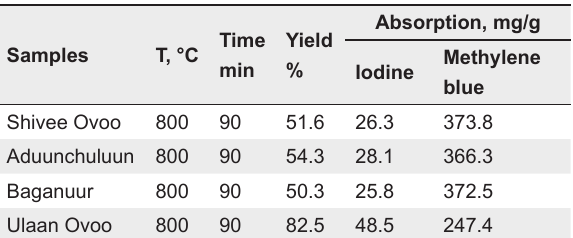
Table 4. The result of activation by preheated water steam, and yield of AC, methylene blue and iodine absorption